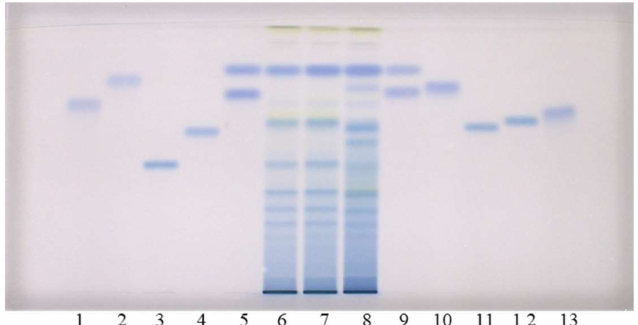
Figure 2. HPTLC chromatograms for the qualitative determination of flavan-3-ols and proanthocyanidins in STSs from leaves (2 µ L, 50 mg / mL) of Japanese (track 6), Bohemian (track 7) and giant (track 8) knotweed based on standards of ( − )-gallocatechin gallate (0.2 µ g; track 1), ( − )- catechin gallate (0.2 µ g; track 2), procyanidin C1 (0.3 µ g; track 3), procyanidin B3 (0.2 µ g; track 4), ( − )-epicatechin (0.1 µ g; track 5, higher R F ), ( − )-epigallocatechin (0.2 µ g; track 5, lower R F ), ( + )- catechin (0.1 µ g; track 9, higher R F ) ( − )-gallocatechin (0.2 µ g; track 9, lower R F ), ( − )-epicatechin gallate (0.2 µ g; track 10), procyanidin B1 (0.2 µ g; track 11), procyanidin B2 (0.2 µ g; track 12) ( − )- epigallocatechin gallate (0.2 µ g; track 13). The HPTLC silica gel plate was developed with the developing solvent toluene-acetone-formic acid (3:6:1, v / v ) and documented after derivatization with DMACA detection reagent at white light